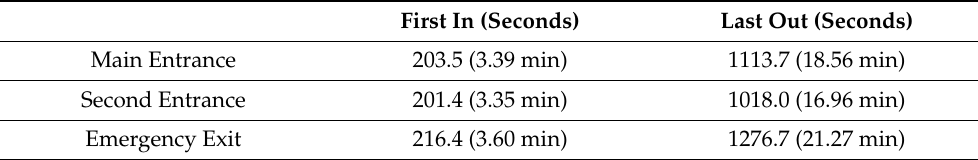
Table 8. Time spent by the first and last occupants for Scenario 8 in Simulation